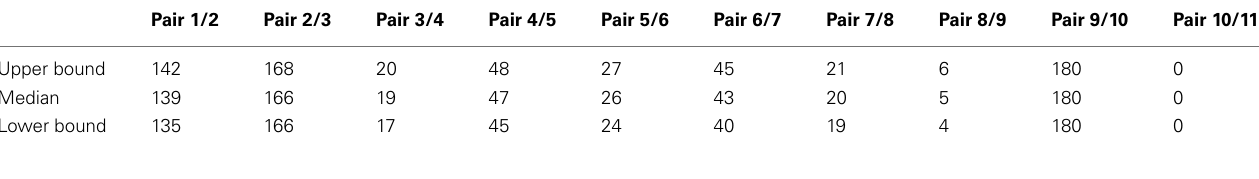
Table 5 | Median and 95% confidence intervals of the angles that minimized the